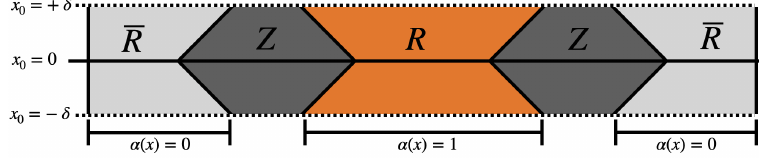
Figure 2 . Geometric configuration used for the definition of twist operators out of Noether currents. The smearing function α ( ~x ) is equal to one for the future and past of R in the time slice ( − δ, δ ) and is equal to zero in the future ans past of ¯ R in the same time